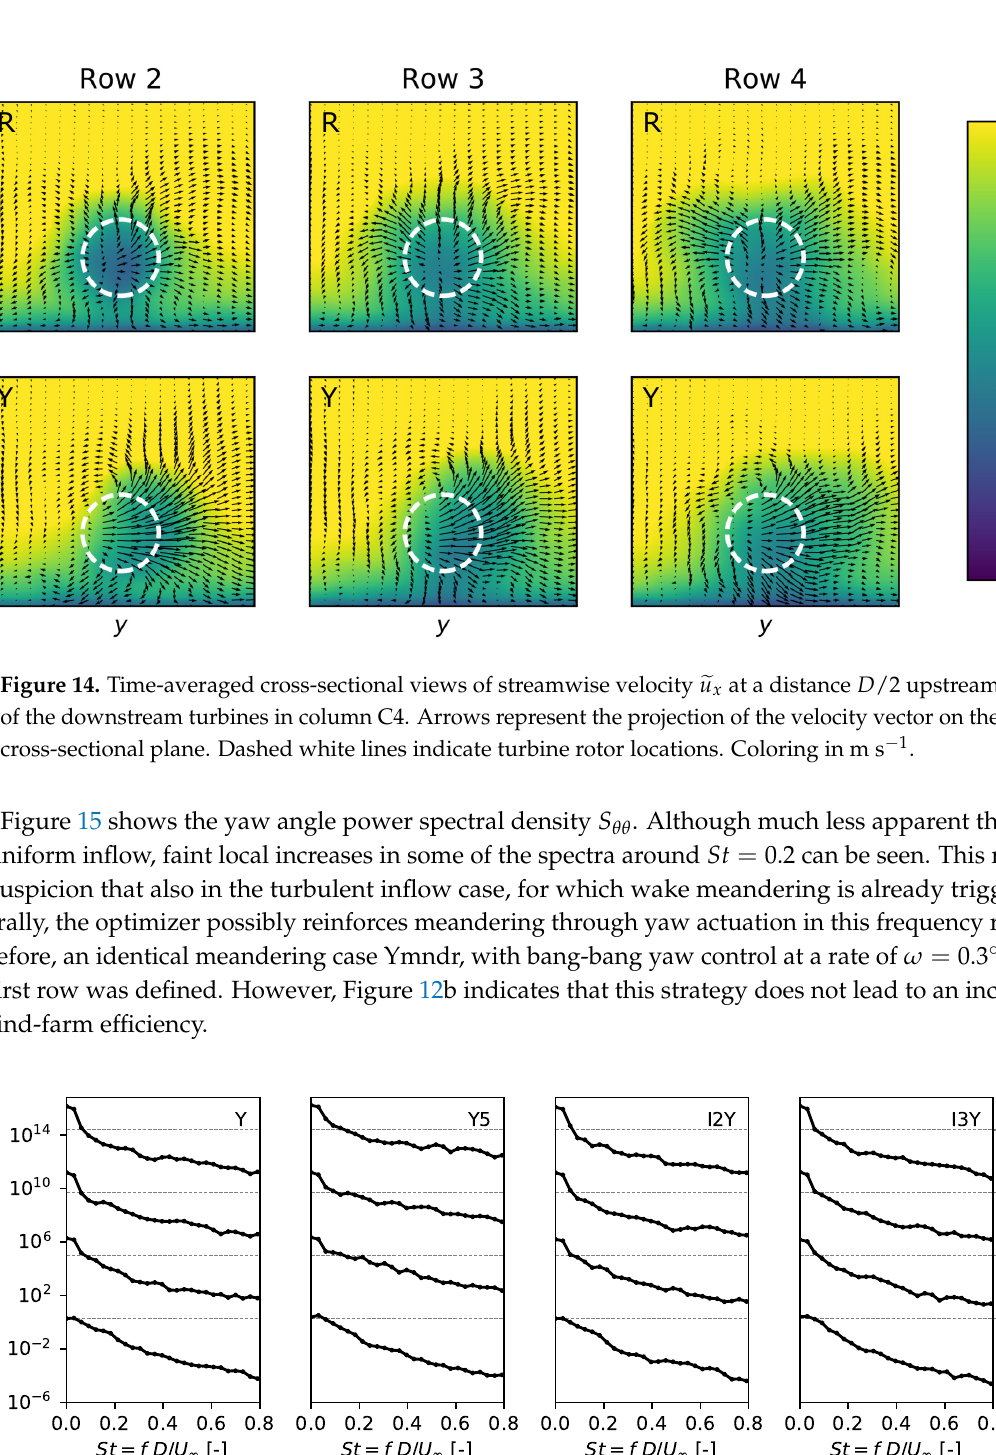
, the row-averaged θ Y